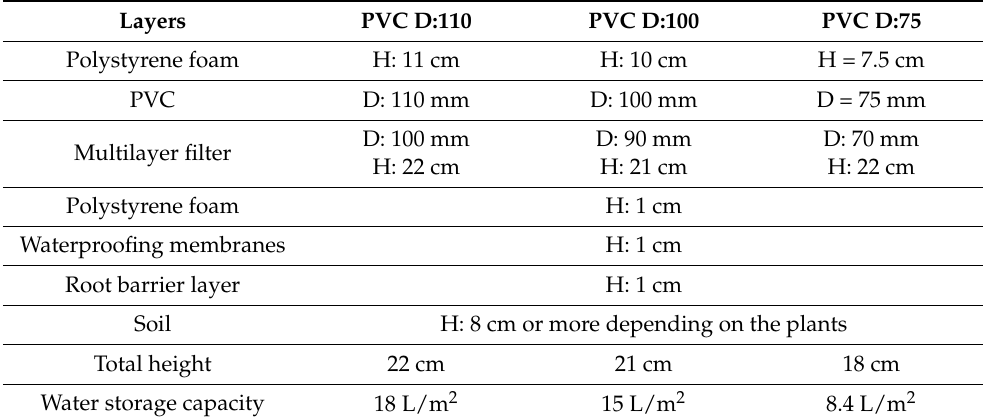
Table 2. Details and water storage capacity of the novel system for three sizes of PVC tube. Layers